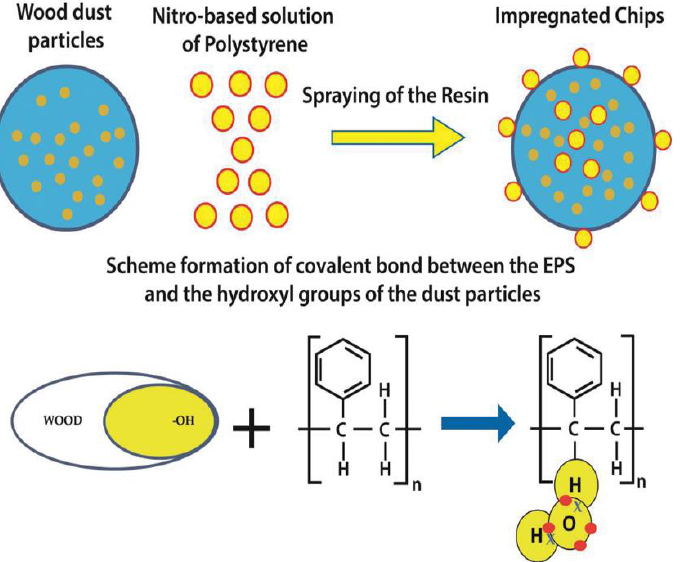
Figure 30. Mechanism of covalent bond formation between the recycled EPS and the sawdust. Reprinted with permission from ref. [73].